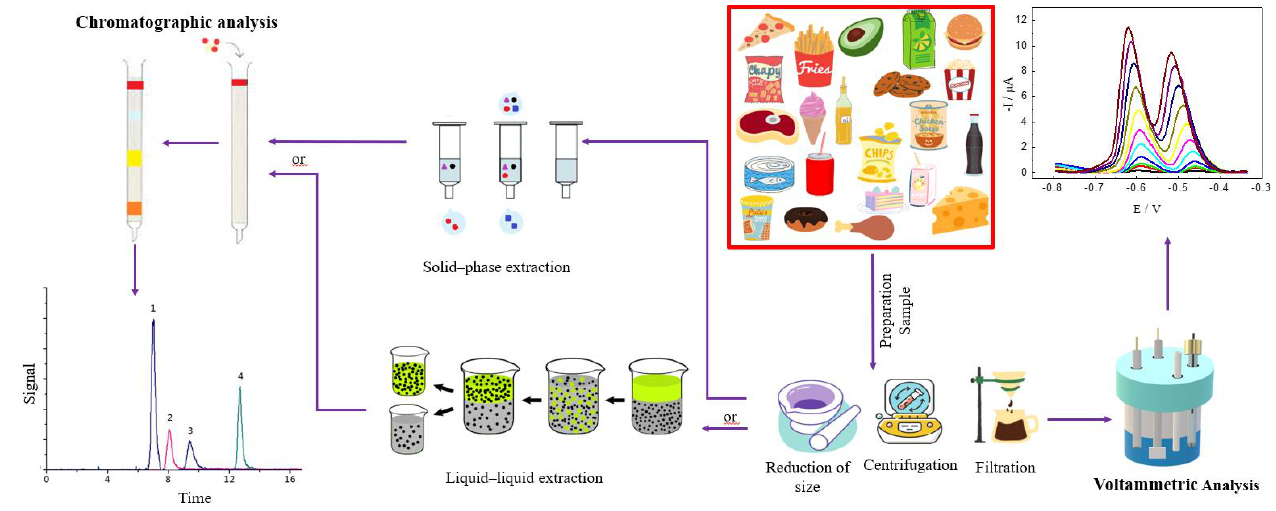
Figure 1. The general scheme employed for the chromatographic and voltammetric analysis of antioxidants indicates the preparation of foodstuff samples in each type of